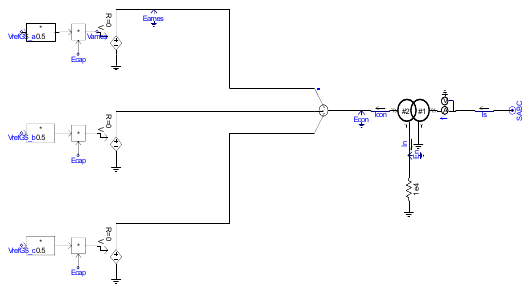
Figure A7. Grid side of the average model of DFIG.